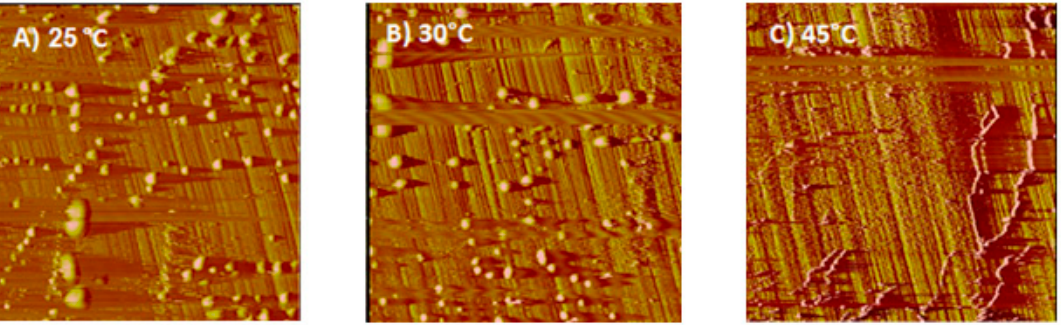
Figure 5. The 30 μ m × 30 μ m atomic force microscope (AFM) deflection images with a 20 nm scale of a chalcopyrite surface soaked in 5 × 10 − 4 M xanthate solutions at different temperatures ( A ) 25 °C; ( B ) 30 °C; ( C ) 45